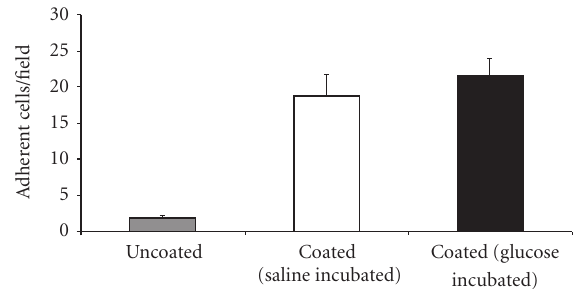
Figure 4: Comparison of adherent cells in microflow chambers per- fused with glucose or saline. Microflow chambers were coated with P selectin, ICAM1, and KC and constantly perfused with isolated glucose-stimulated or saline control bone marrow neutrophils of LysEGFP mice ( n = 4). Adhesion of leukocytes in fully coated flow chambers was compared to uncoated flow